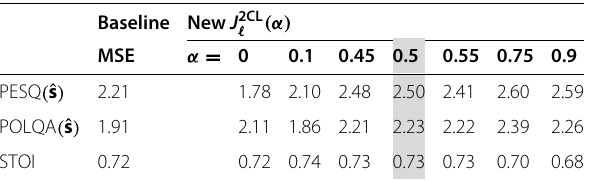
on 12 . 5 % of the validation set . The selected setting is gray-shaded Baseline New J 2CL